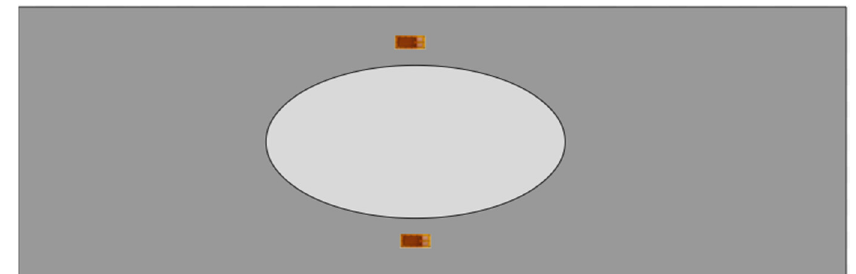
Figure 6. The position of strain gages installed around a hand-hole.